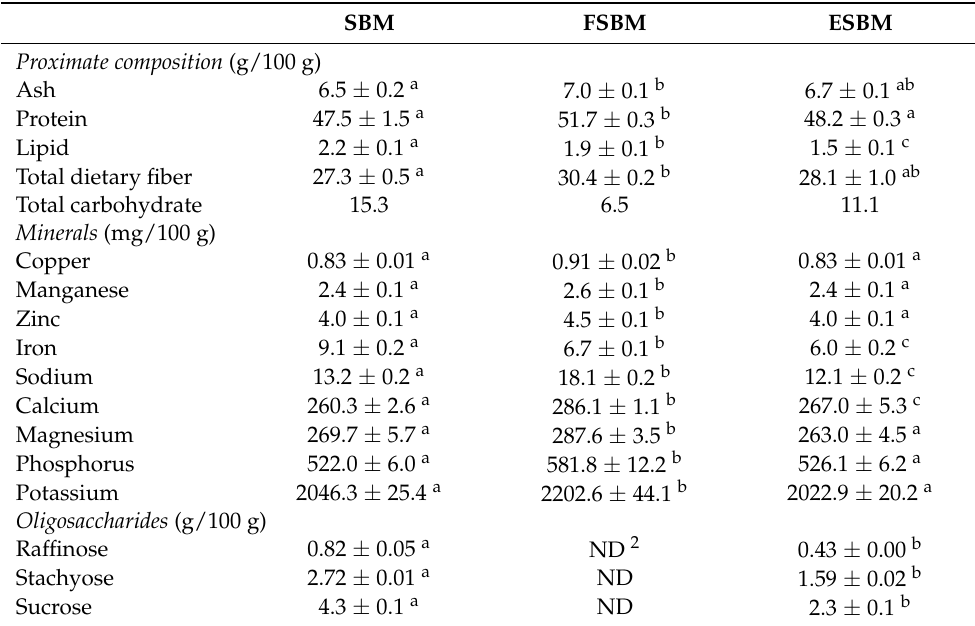
Table 1. Proximate composition, minerals and oligosaccharides profile of soybean meal (SBM), fermented soybean meal (FSBM) and enzymatically-processed soybean meal (ESBM) 1